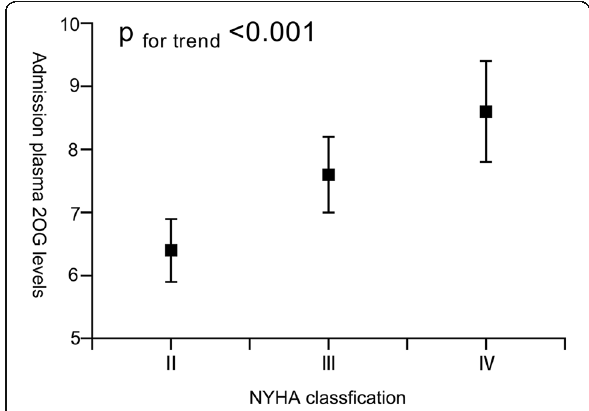
Fig. 2 Relationship between the admission plasma 2OG levels and NYHA classification. We calculated the adjusted mean (adjusted for age, sex, and BMI) of 2OG levels for each NYHA classification subgroup. 2OG: 2-oxoglutarate, BMI: body mass index, NYHA: New York Heart Association